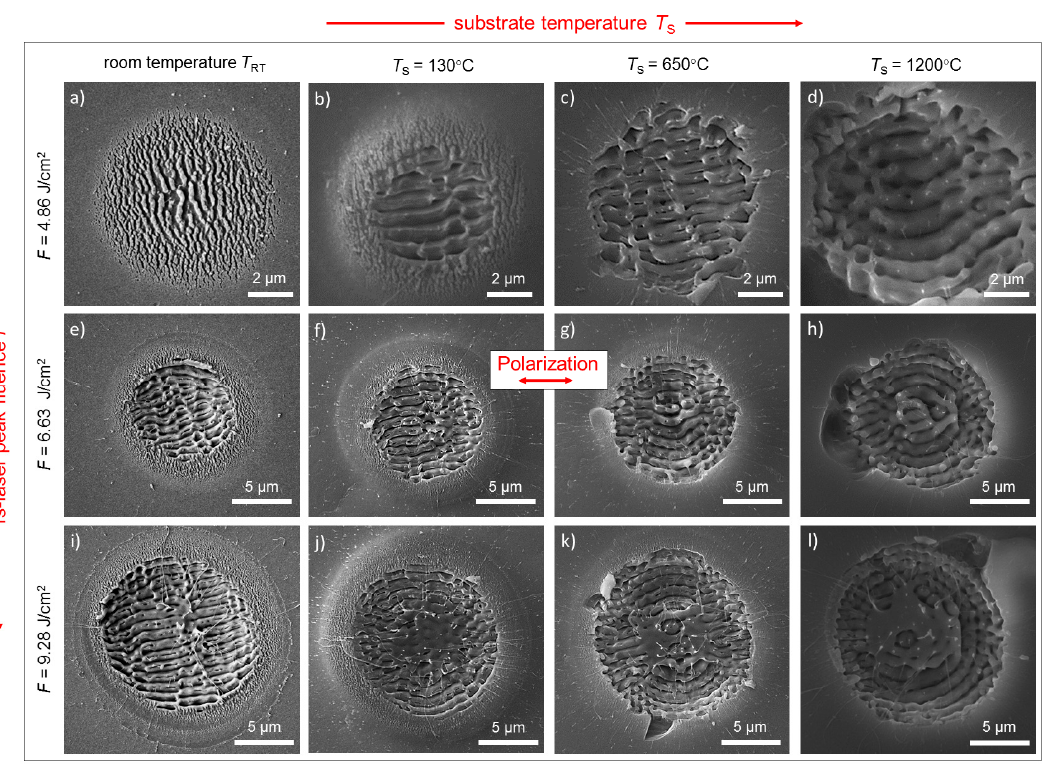
Figure 3. Scanning electron microscopy (SEM) micrographs of the fused silica surface upon irradiation with linearly polarized laser pulses ( N = 5) at T RT , T S = 130, 650, and 1200 °C using ( a – d ) F = 4.86 J/cm 2 , ( e – h ) F = 6.63 J/cm 2 , and ( i – l ) F = 9.28 J/cm 2 . Note the direction of the beam polarization (red arrow) and the different scaling of the SEM micrographs.